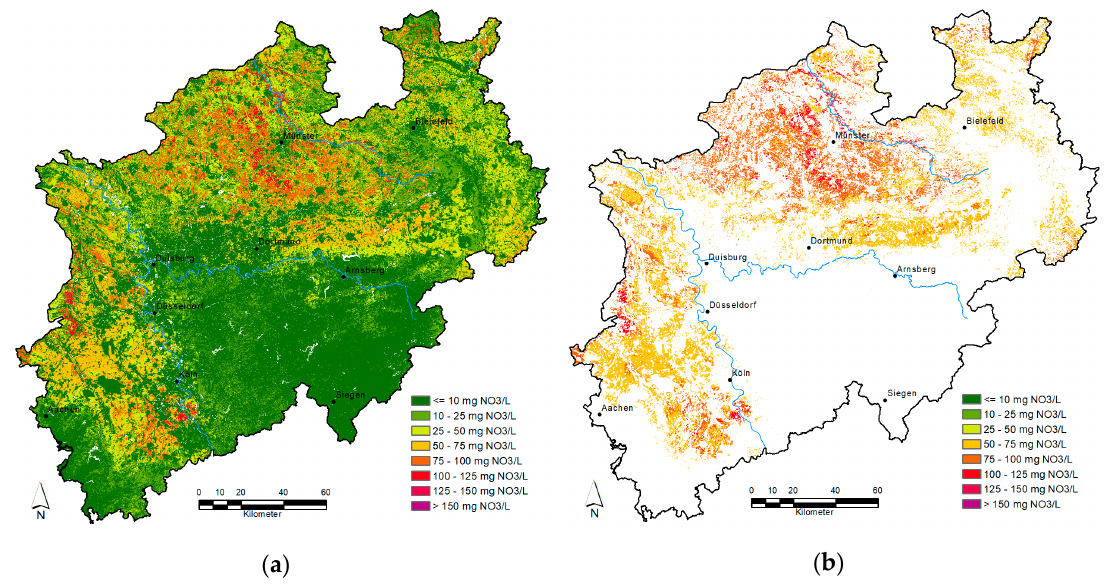
Figure 5. ( a ) Nitrate concentration in the leachate originating from agricultural sources, and ( b ) areas showing nitrate concentrations in the leachate above 50 mg NO 3 /L due to agricultural N emissions.